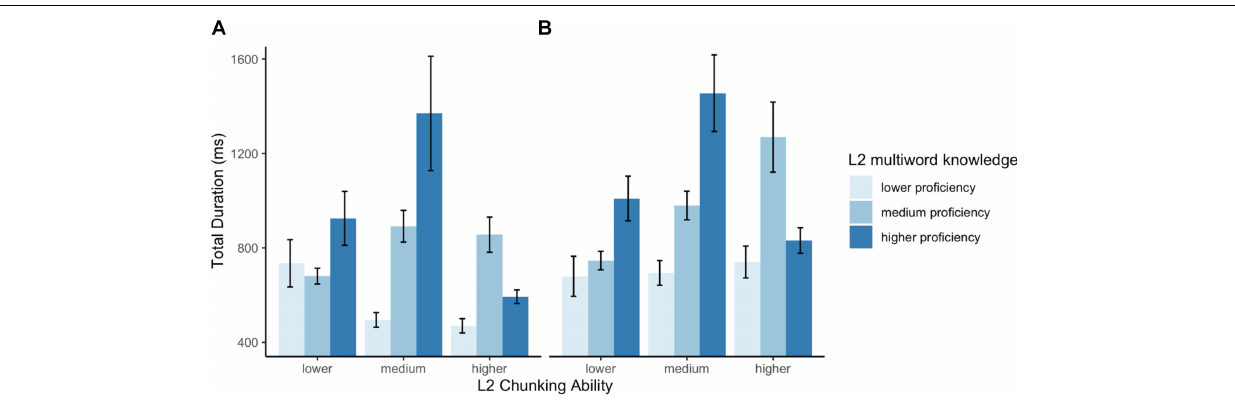
FIGURE 5 | Effects of L2 chunking ability and multiword knowledge on verb total duration times for in (A) congruent and (B) incongruent multiword units. Levels of L2 chunking ability are represented in the horizontal axis, and levels of L2 multiword knowledge are shown in column colors. L2 multiword knowledge serves as the critical L2 proficiency measure. Error bars represent the standard